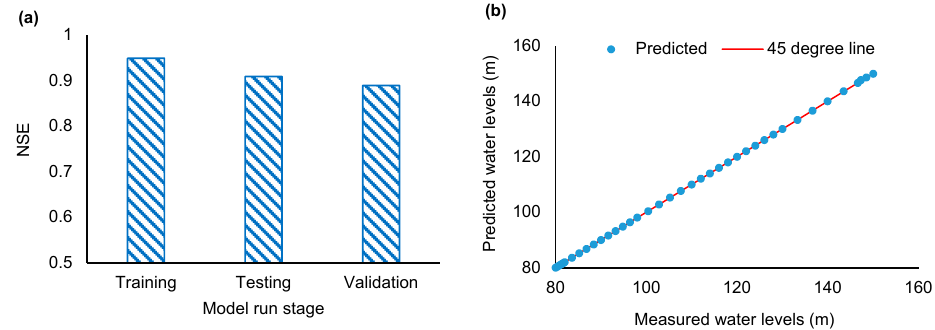
Figure 8. ANFIS Results for groundwater modeling; ( a ) Performance indicator, ( b ) Predicted verses observed groundwater levels. observed groundwater